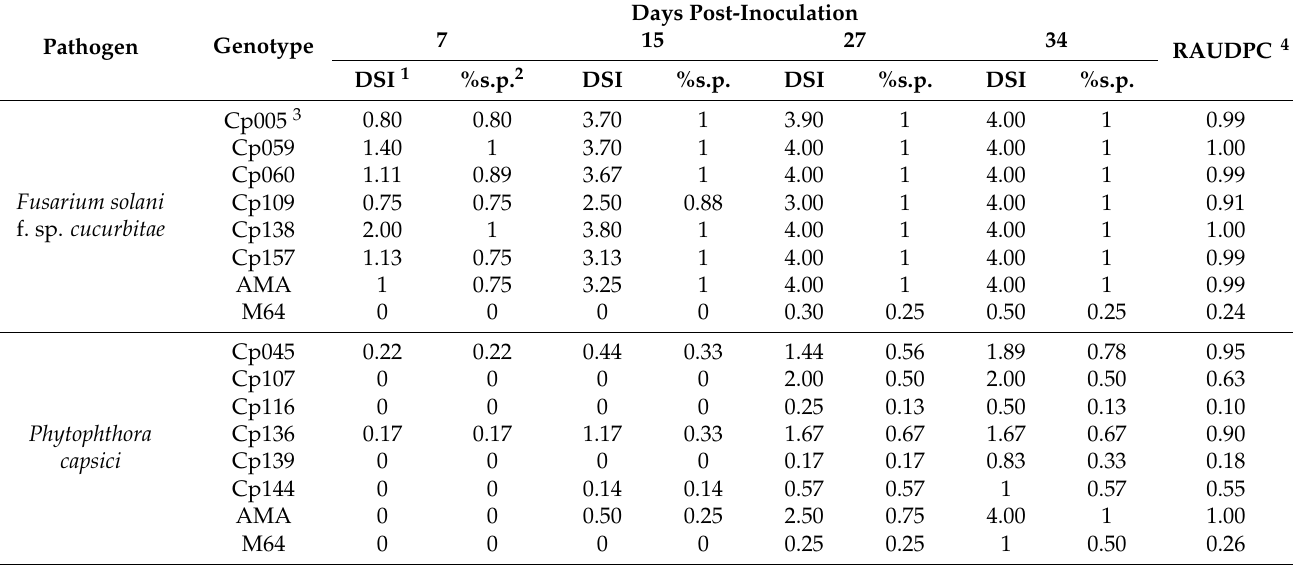
Figure 2. Disease symptoms caused by Phytophthora capsici and Fusarium solani f. sp. cucurbitae in Cucurbita pepo . Shoot symptomatology in seedlings 14 dpi ( 1 – 4 ): DSI 0 = no symptoms ( 1 ); DSI 1 = soaked crown ( 2 ); DSI 2 = constricted crown ( 3 ); DSI 4 = death ( 4 ). Shoot symptomatology 14 dpi in plants inoculated when they reached 2–3 true leaves ( 1 – 4 ). In some cases, pathogen damage was different between plants in the same pot ( 5 ): dead plant (left) and plant show no symptoms (right). Leaf epinasty ( 6 ), soaked and constricted crown ( 7 ), and wilted and dead ( 8 ) plants. Table 3. Phytophthora capsici and Fusarium solani f. sp. cucurbitae disease evolution in selected mutant